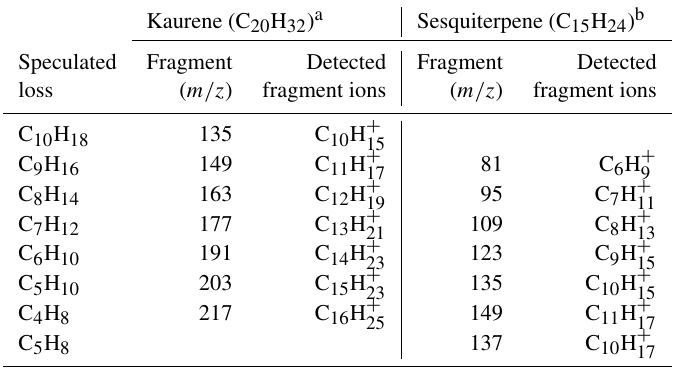
Figure 7. Fragments in Vocus. Panels (a) – (g) show the relationship between the signals of kaurene and its fragments in Vocus. Kaurene and its fragments are shown with raw signal intensities without corrections, colored with FIMR pressures ranging from 0.9 to 1.4mbar. Panel (h) shows the fraction of the fragments as a function of FIMR pressures in Vocus. (Fraction represents the signal of the individual fragment divided by the total signal of all fragments.) Table 2. A summary of fragmentation patterns of diterpenes and sesquiterpenes. The E/N is ∼ 120Td for all studies listed here. The speculated loss represents the possible neutral molecules lost from the parent ion to form the detection